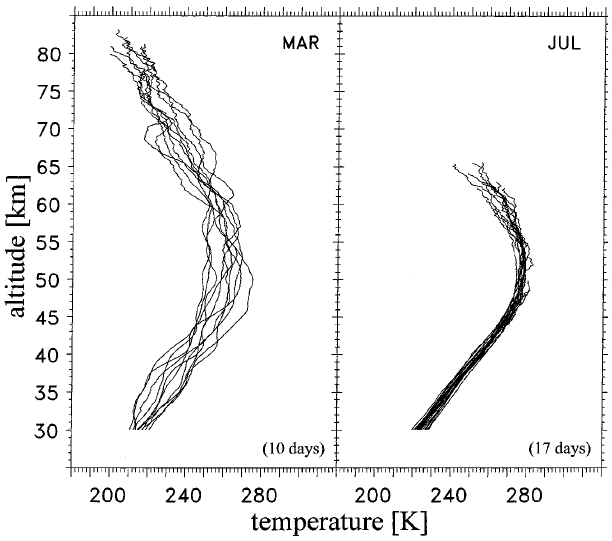
Fig. 12. Examples of automatically processed temperature profiles, including daily mean profiles obtained by the RMR lidar during darkness in March 1998 and during daytime in July 1998. The upper end of the profiles is chosen at an altitude where the statistical error bar reaches